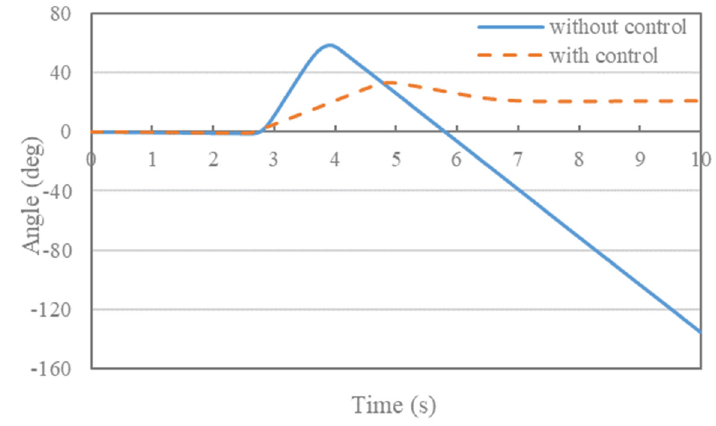
Figure 10. Time history of rotation angle for condition 1-1.